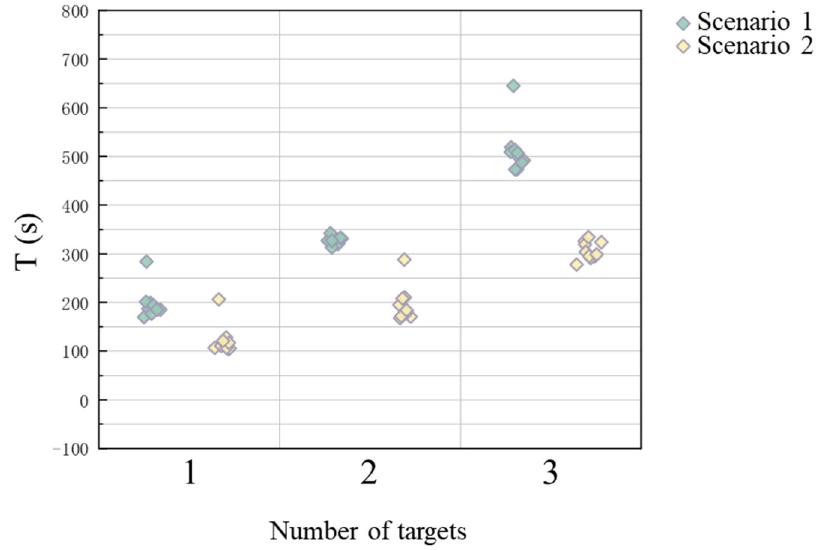
Figure 7. Efficiency comparison of the task allocation. This figure presents the time from the beginning to the completion of each experiment in seconds. Scenario 1 corresponds to two altruistic robots, and Scenario 2 involves one altruistic robot. The efficiency of task completion is not simple, nor does it mean that the more altruistic individuals are better.